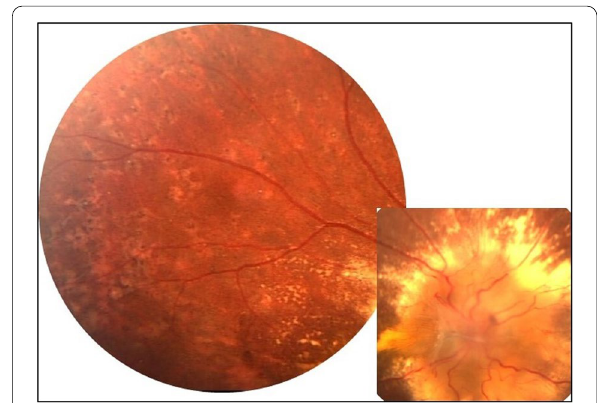
Fig. 2 Montage color fundus photograph of the right eye of a patient with hypertensive retinopathy showing severe papilledema with exudation and pigmented Elschnig spots with atrophic halo